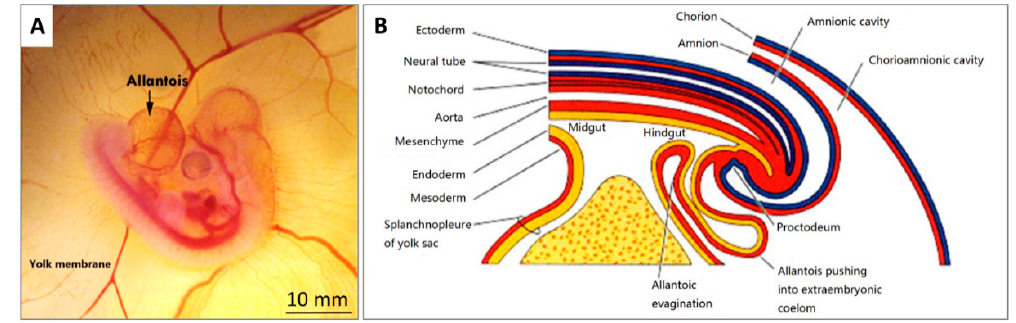
Figure 3. ( A ) A photo of a fertilised chick egg at day 4 post-incubation and ( B ) a schematic drawing displaying how the allantois is formed.